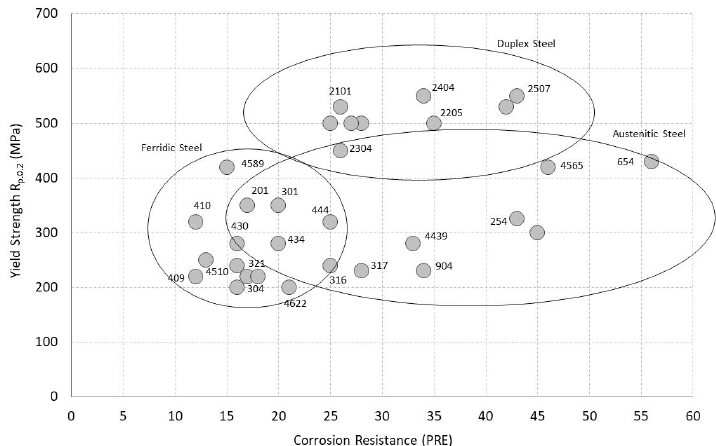
Figure 1. Corrosion resistance (PRE) vs. stainless yield strength (indicative) for different stainless steel grades. Reproduced from [29], with permission from Elsevier, 2018.